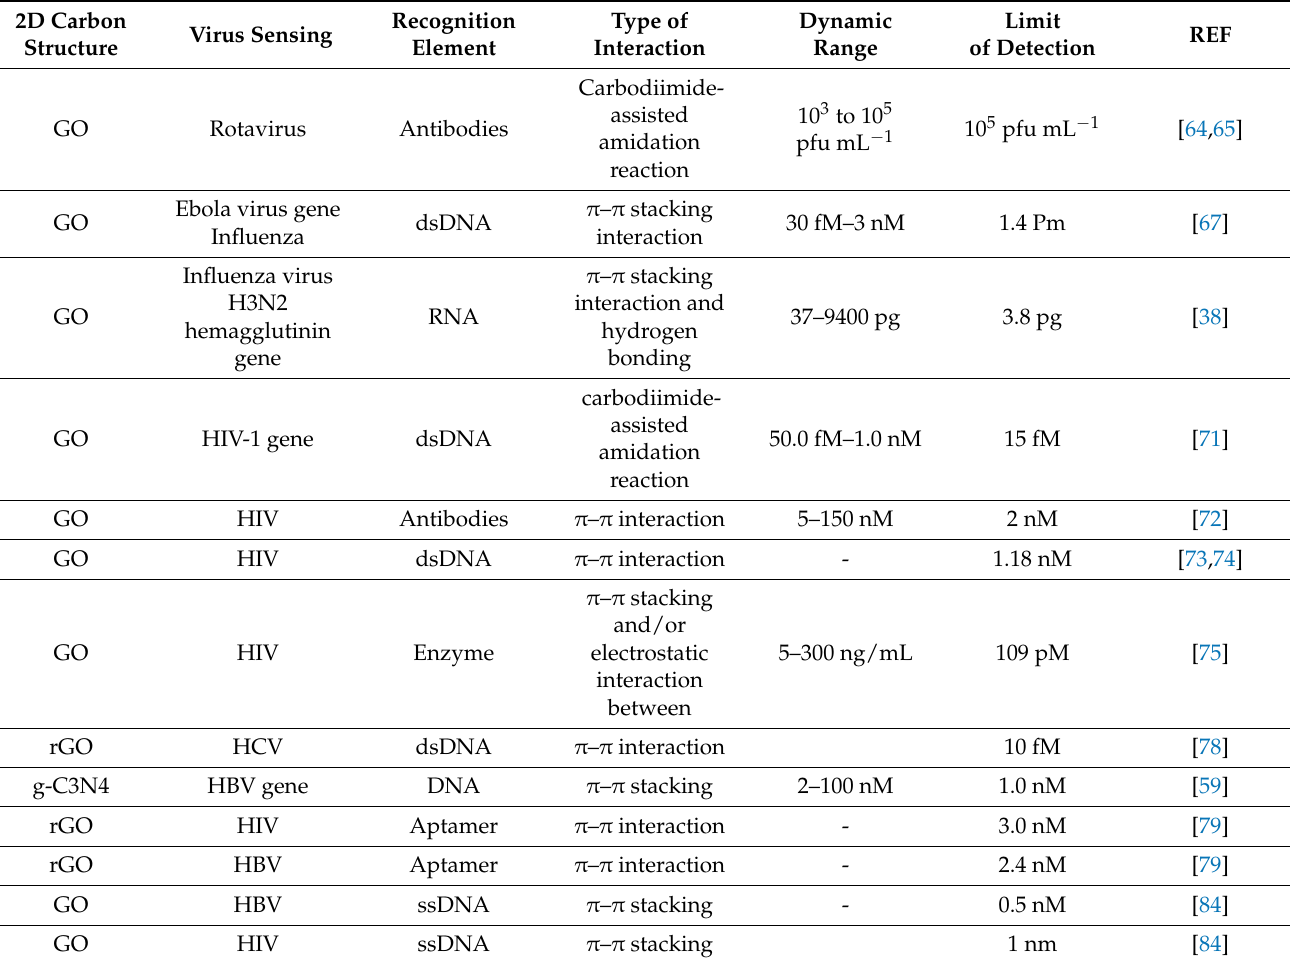
Table 1. List of the 2D fluorescent biosensors available for virus detection, types of employed recognition element, dynamic range, and limits of detection